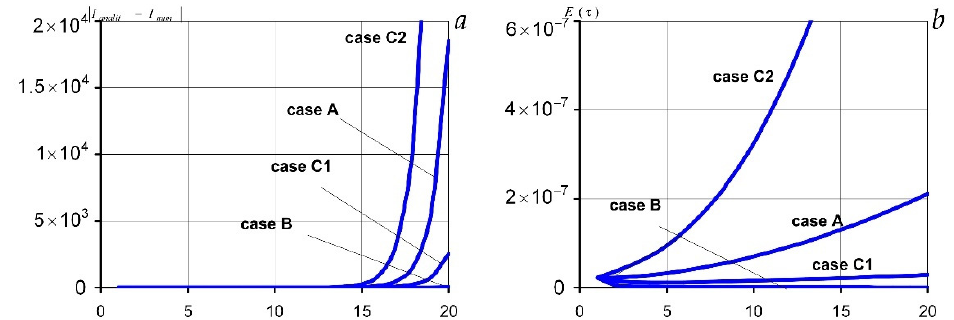
Figure 9. Graphs of absolute ( a ) and relative ( b ) errors for four considered cases of A, B, C1, and C2 of the relation between the number of nodes and grid width for the integrand f ( τ (cid:48) , τ (cid:48)(cid:48) ) = exp( τ (cid:48) ) τ (cid:48)(cid:48) . τ (cid:82) Table 5. Calculation of integral 0